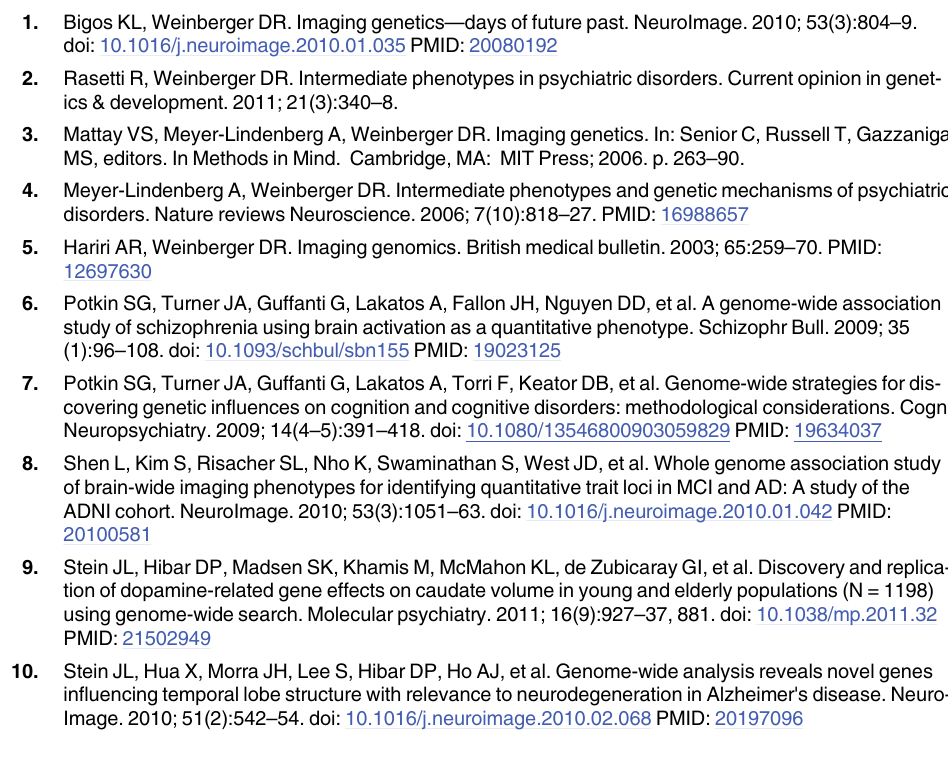
S4 Fig. Comparisons of effect size for different parameters used in measure 4 (percentile = top 25%, 10%, and 5%), measure 6 (top N = 10, 20, and 50 voxels), measure 7 (sphere radius = 6, 7.5, and 10 mm), and measure 8 (correlation coefficient r = 0.7, 0.8, and 0.9). Panel a shows the combined the results of the two-sample t tests by averaging the effect sizes from dataset 1 and 4 together; and panel b shows the combined the one-way ANOVA results by averaging the effect sizes from dataset 2 and